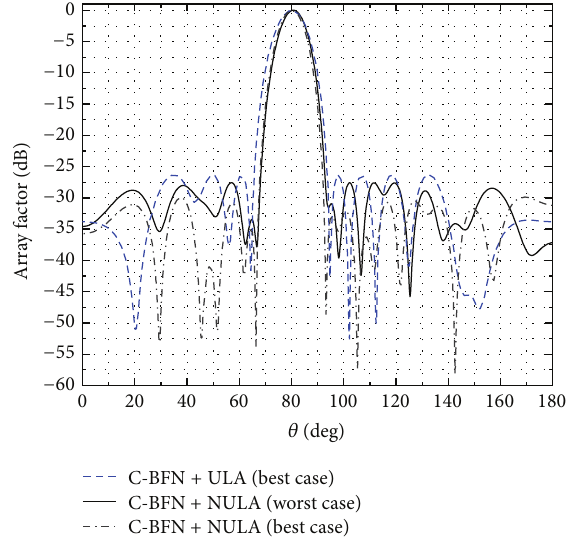
Figure 4: Comparison between the array factor of the best case of a ULA, the worst case of a NULA, and the best case of a NULA obtained by the proposed C-BFN, showing an example of beam #1 directed at 80 ∘ .